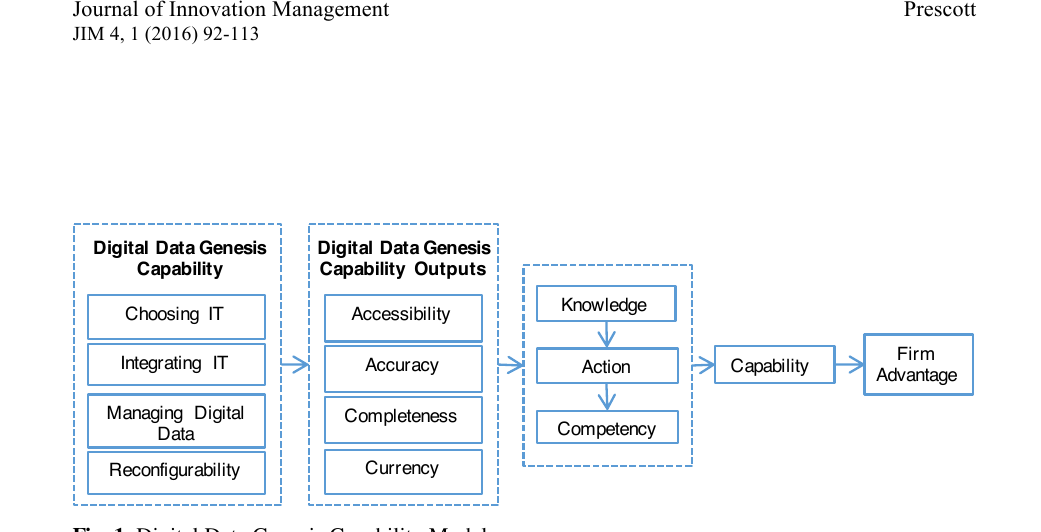
Fig. 1. Digital Data Genesis Capability